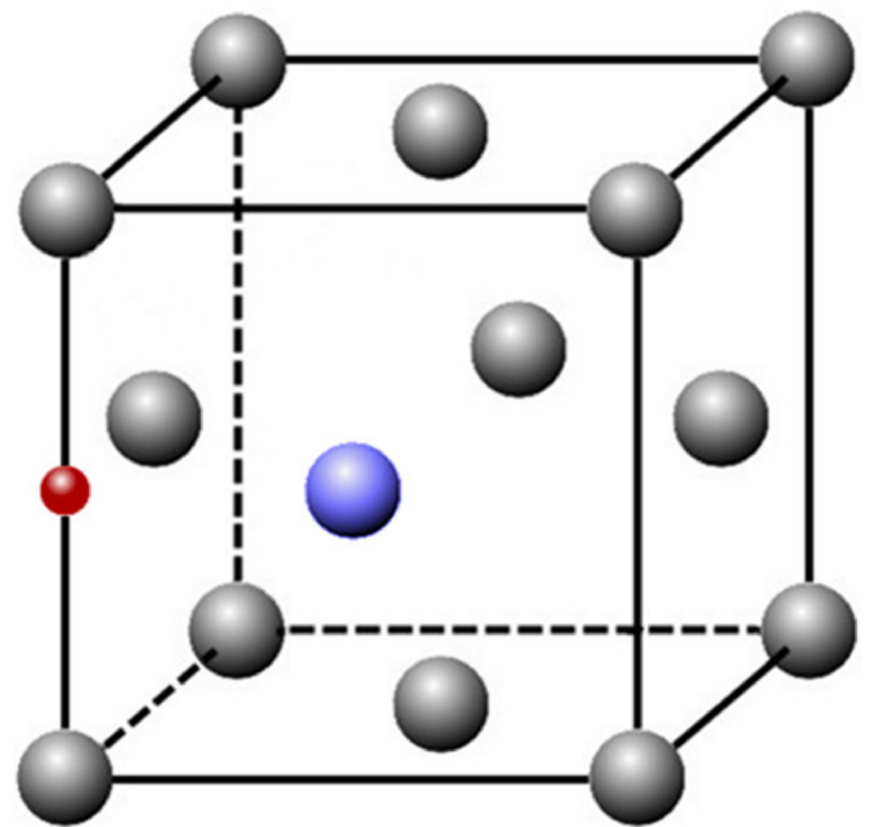
Figure 1. The positions of Mn (blue) and C (red) atoms in a f.c.c. Fe lattice (gray atoms). (The positions of the atoms are shown without taking into account structural